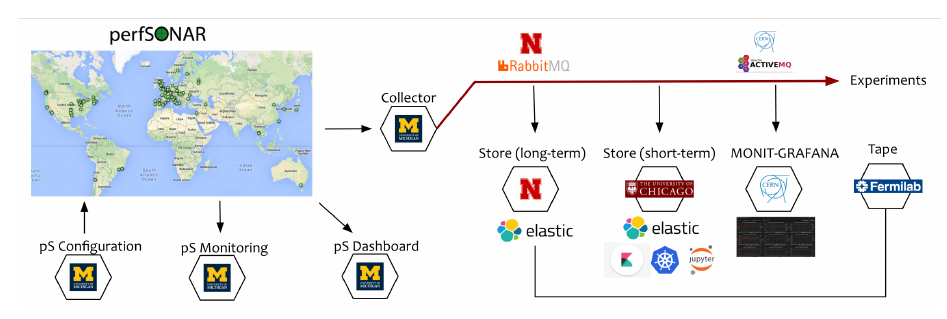
Figure 2: OSG Network Monitoring Platform - distributed deployment that collects, stores, visualises and provides APIs for the measurements collected by the WLCG perfSONAR